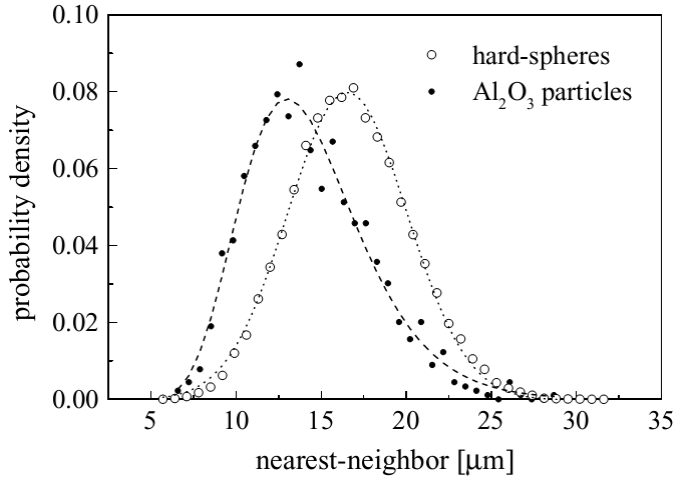
Figure 19. Probability distribution of nearest-neighbor distance